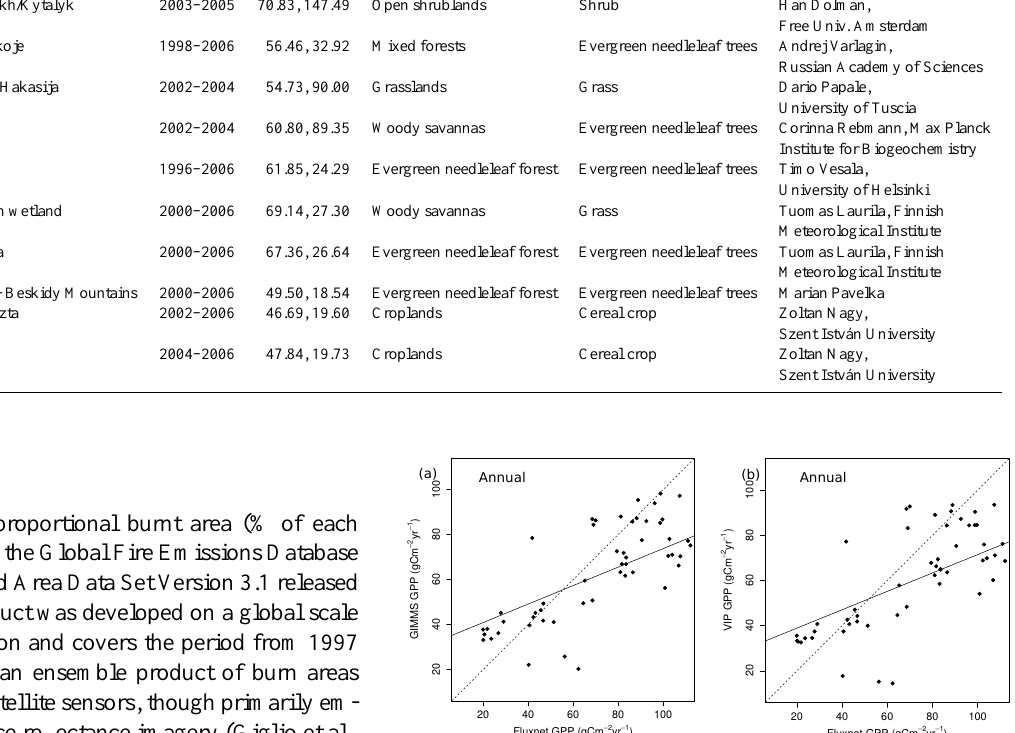
where 0 is no correlation and − 1 / + 1 is total negative or positive correlation respectively. 2. Percent bias, which measures the average tendency of the simulated values to be larger or smaller than the cor- responding observations. The optimal value is 0.0 with low-magnitude values indicating accurate model sim- ulations. Positive values indicate overestimations and vice versa (Yapo et al., 1996; Sorooshian et al., 1993). 3. The Nash–Sutcliffe efficiency (NSE) coefficient, which is a normalized statistic that determines the relative magnitude of the residual variance compared to the measured data variance (Nash and Sutcliffe, 1970). The statistic indicates how well the plot of observed vs. sim- ulated data fits the 1 : 1 line. Nash–Sutcliffe efficiencies range from −∞ to 1. An efficiency of 1 corresponds to a perfect match of model-simulated GPP to the